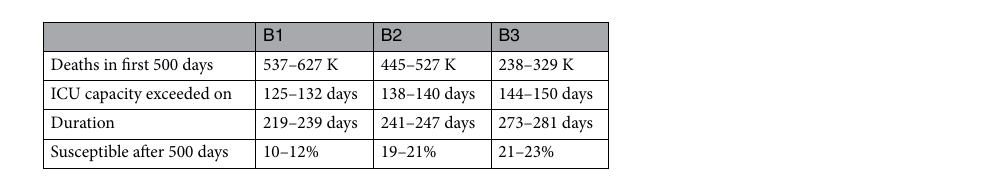
Table 5. Results for the benchmark